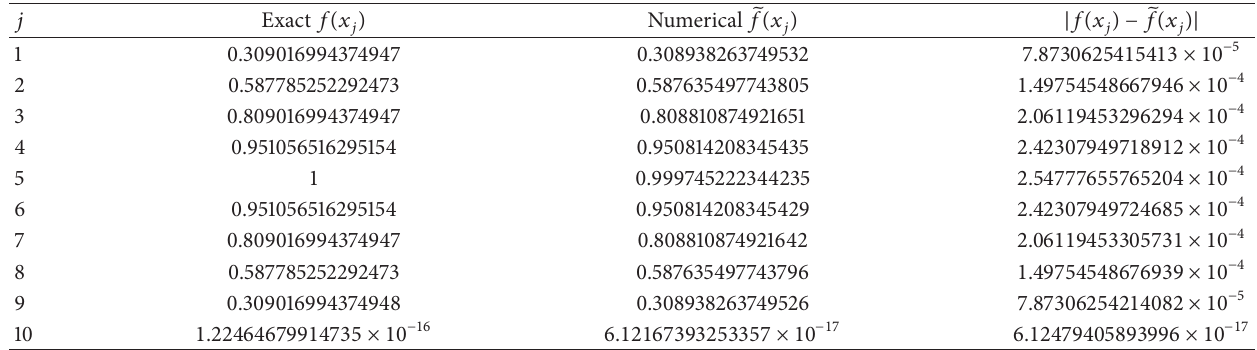
Table 6: 𝑇 = 1 , the analytical and numerical results for the 𝑓(𝑥 𝑗 ) in 𝑥 𝑗 = 0.1𝑗 , where 𝛿 = 0.1